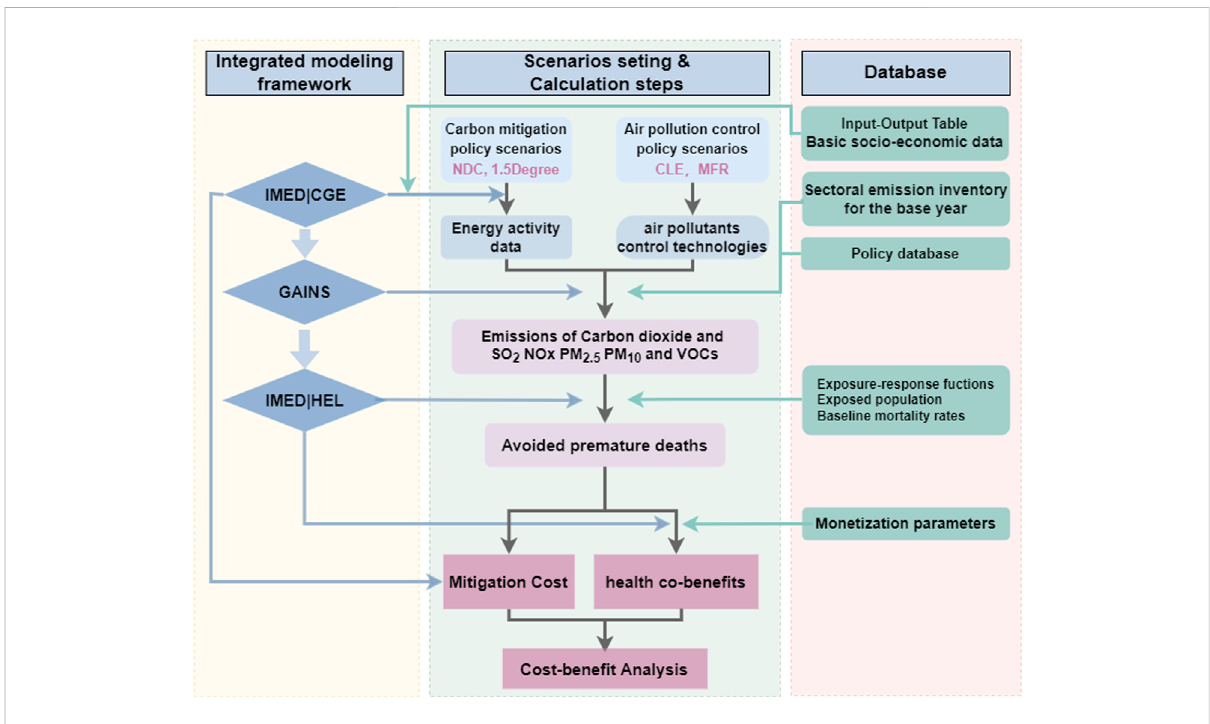
FIGURE 1 Integrated modeling and research